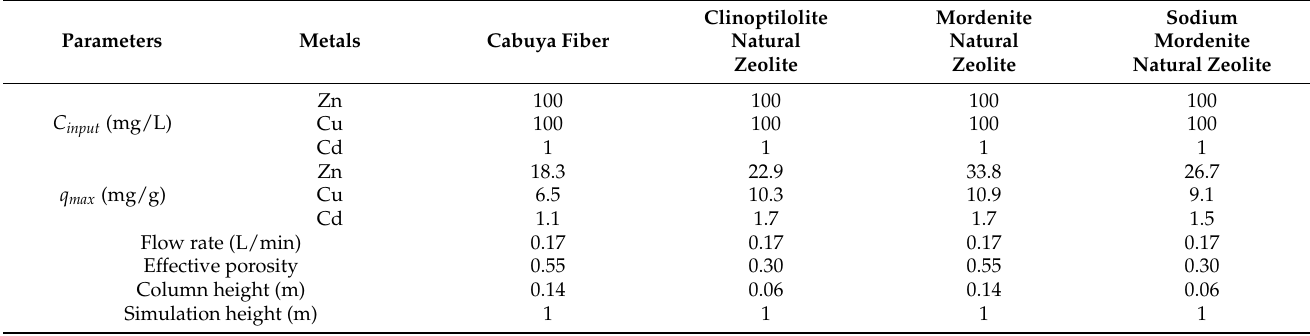
Table 8. Input parameters of simulation by RETRASO